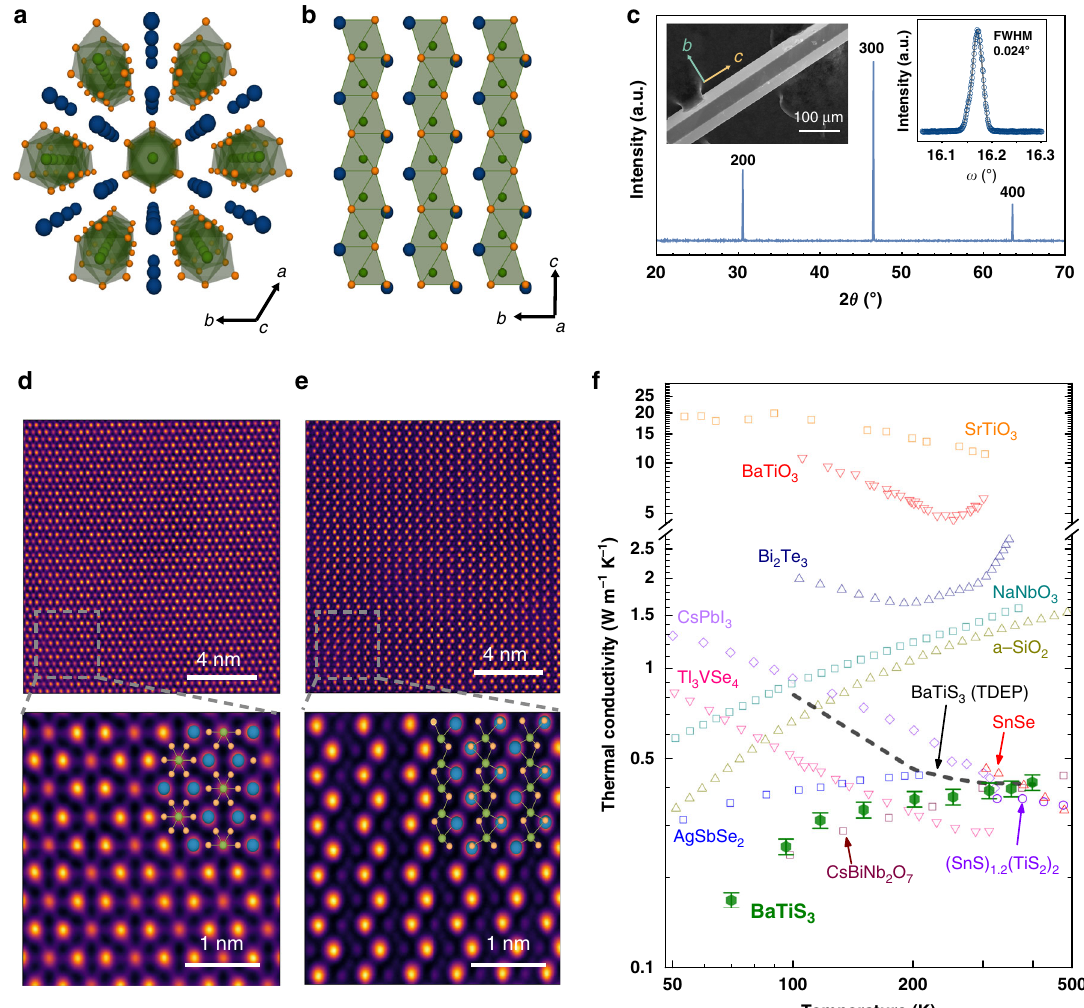
Fig. 1 Structural and thermal transport properties of BaTiS 3 single crystal. Illustration of the BaTiS 3 structure in perspective view along c axis ( a ) and projected down a axis ( b ). Blue and orange spheres denote Ba and S atoms, respectively. Octahedra formed by Ti and six surrounding S atoms are highlighted in green. c XRD measurement of a crystal to identify the crystallographic directions. The left inset panel of c is an SEM image of the sample for which thermal conductivity was measured using TDTR. The right inset panel of c is the rocking curve for the 200 re fl ections. STEM HAADF images showing c axis ( d ) and a axis ( e ) projection of BaTiS 3 . The bottom panels show the high-resolution HAADF images with overlaid atomic models. f Measured thermal conductivity versus temperature for BaTiS 3 (green) and other materials from literature. First-principles calculations using temperature- dependent effective potential (TDEP) method are also shown (black dashed line). Data for BaTiO 3 and SrTiO 3 , amorphous silica (a-SiO 2 ), Bi 2 Te 3 , CsBiNb 2 O 7 , CsPbI 3 , NaNbO 3 , Tl 3 VSe 4 , AgSbSe 2 , SnSe and (SnS) 1.2 (TiS 2 ) 2 are from refs. 4,16,18,19,21,26,41,69,70 , respectively. The estimation of error bars is detailed in Supplementary